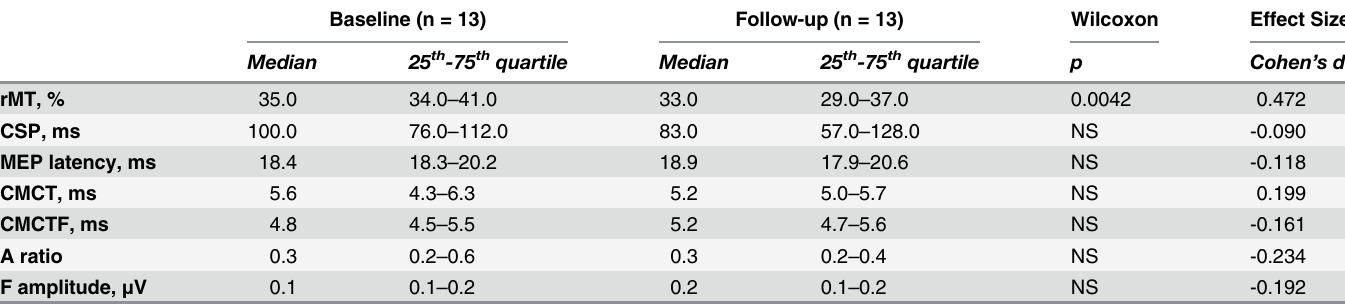
Table 3. Comparison of electrophysiological